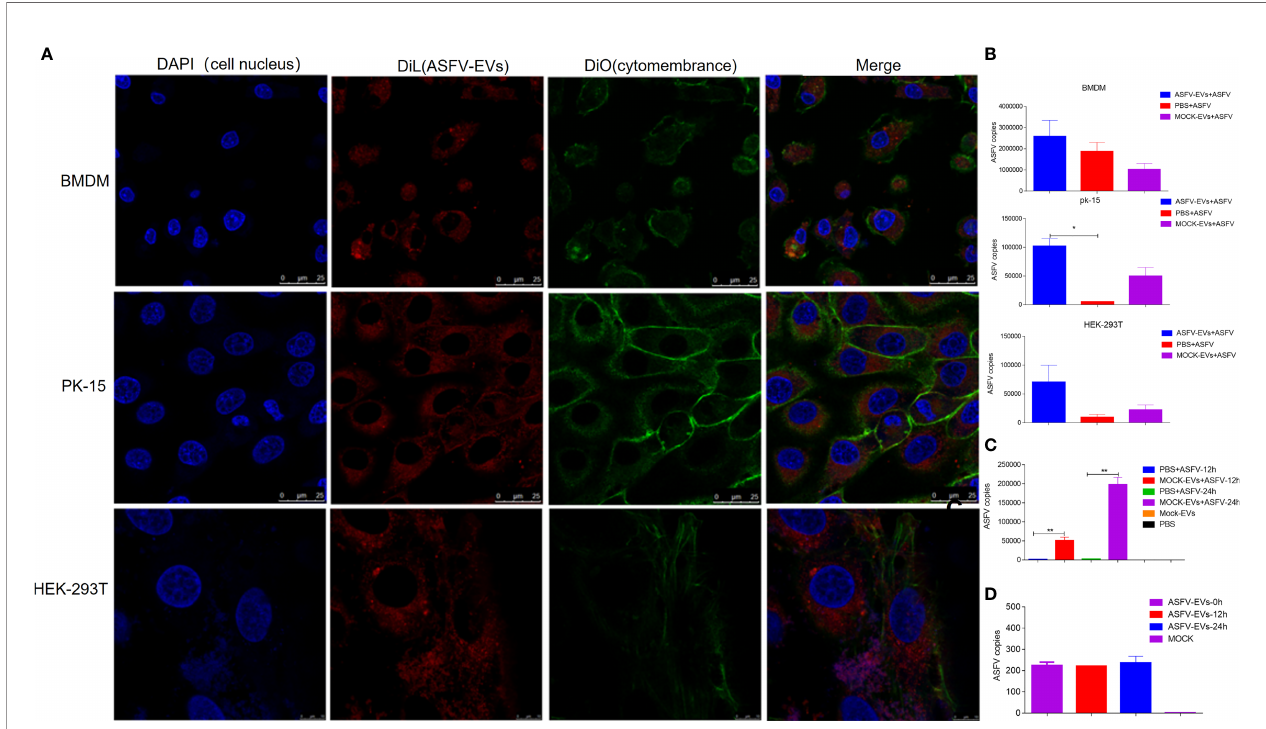
FIGURE 2 | Extracellular vesicles mediate ASFV replication in ASFV-susceptible and non-susceptible cells. (A) Extracted ASFV-EVs was pre-stained with DiL and then inoculated into susceptible and non-susceptible cells for 8 h cell. Cell nucleus and cytomembrane were stained with DAPI (4 ’ ,6-diamidino-2-phenylindole) and DiO respectively. Meanwhile, fl uorescence was measured by confocal laser microscopy. (B) The extracted ASFV-EVs (25ng) were inoculated into susceptible cells (BMDM) and non-susceptible cells (HEK-293T, PK-15) 8 h, meanwhile PBS was used as control, and then inoculated with ASFV(MOI:0.01). After 24 h of inoculation with ASFV, the cells and culture supernatant were collected, and DNA was extracted to detect the viral load of ASFV. (C) The extracted MOCK-EVs (50ng) were inoculated into PK-15 cell 8 h, meanwhile PBS was used as control, and then inoculated with ASFV(MOI:0.01), meanwhile, cells treated only with MOCK-EVs were used as negative control. At 12h and 24 h after ASFV treatment respectively, the cells and culture supernatant were collected, and DNA was extracted to detect the viral load of ASFV. (D) The extracted ASFV-EVs (25ng) were inoculated into BMDM cell, meanwhile PBS was used as control. At 0h 12h and 24 h after inoculated with ASFV-EVs respectively, the cells and culture supernatant were collected, and qPCR was performed to detect the p72 gene of ASFV.All data represent means ± SD, n = 3 for each group. A signi fi cant difference was calculated using a two-tailed t -test and labeled as *P < 0.05 and **P < 0.01 in